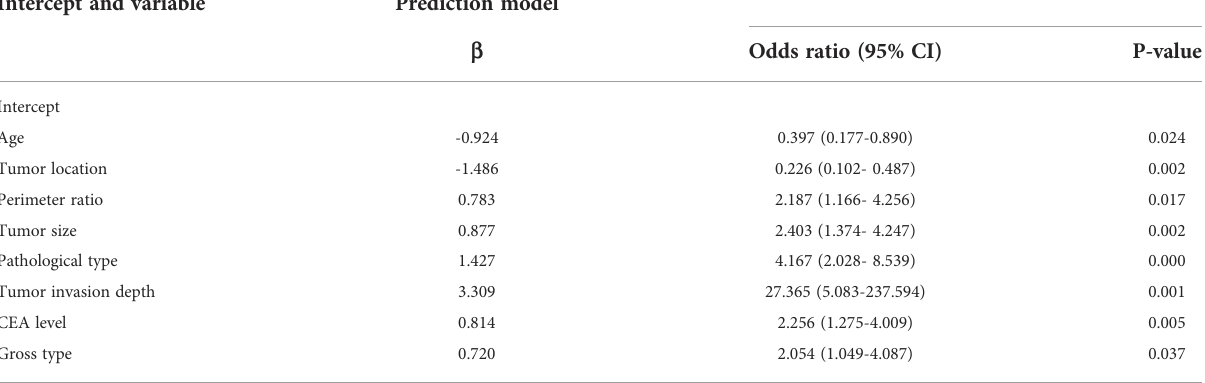
TABLE 2 Predictors in the risk nomograms for PMCC using multivariate logistic regression.